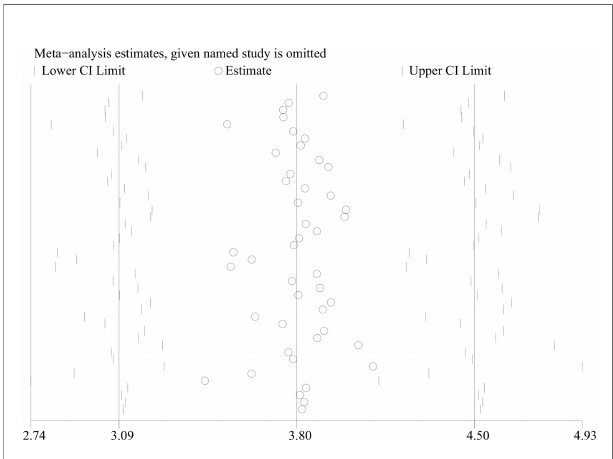
FIGURE 3 | Sensitivity analysis of studies on leptin levels in patients with OSAS versus controls. OSAS, obstructive sleep apnea